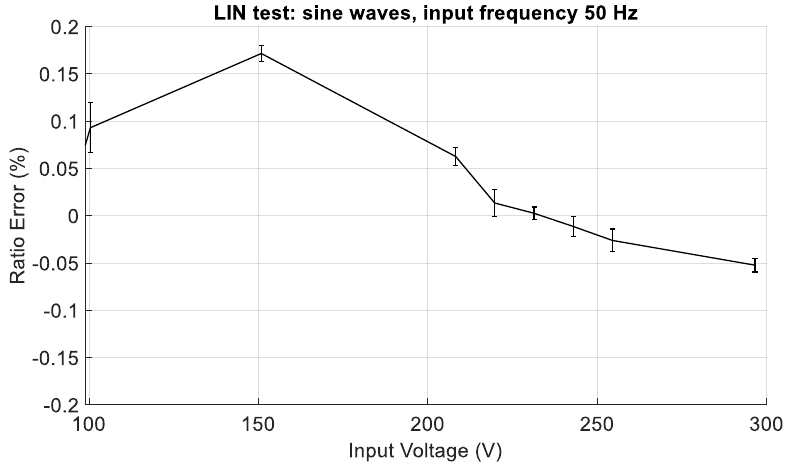
Figure 14. Zoom of Figure 13: ratio error in the LIN tests, with sinusoidal input voltage with frequency of 50 Hz and amplitudes from 100 V to 295 V